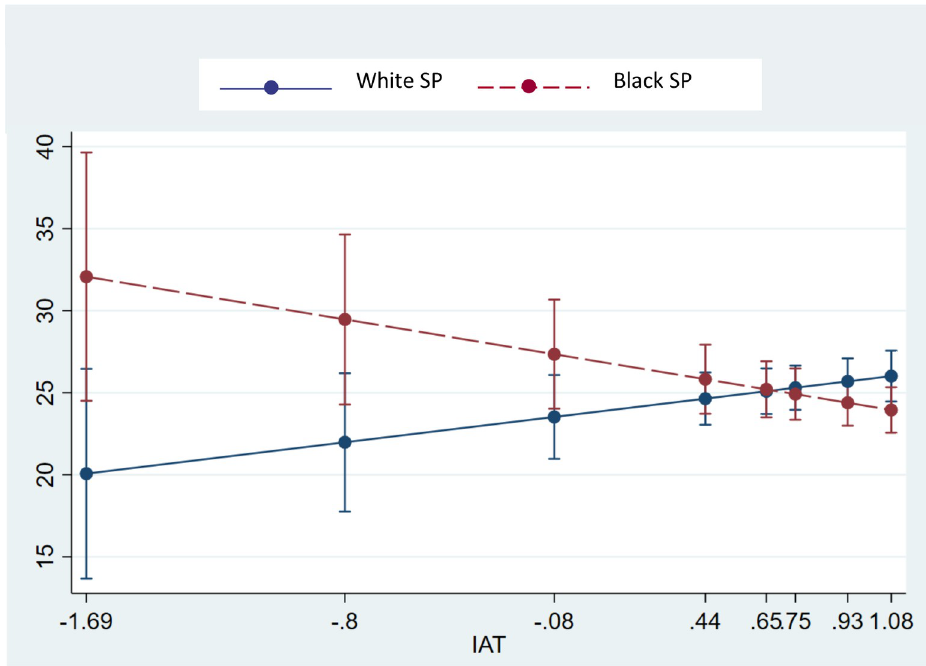
Fig 3. Interaction of IAT & race on PCC pain